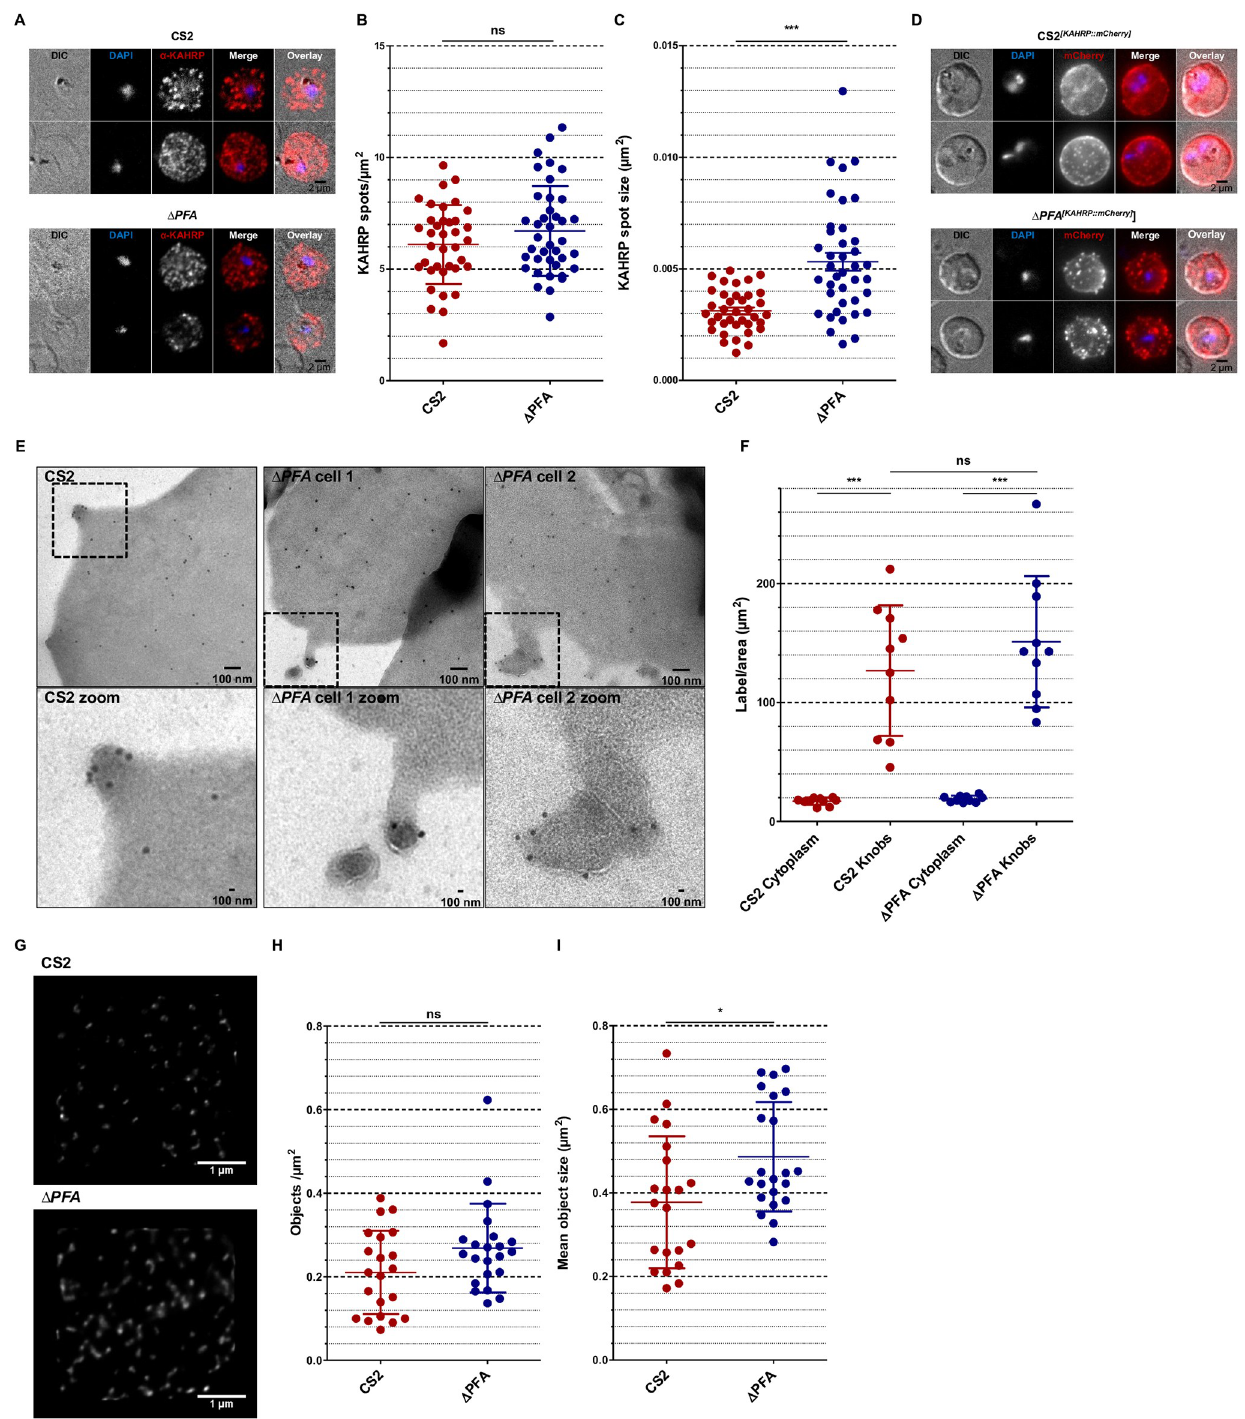
Fig 3. Δ PFA iRBCs display altered KAHRP distribution. A) IFA assay of MeOH-Ac-fixed CS2 and Δ PFA using α -KAHRP antibodies reveals punctate patterns. A trend was noticed towards bigger spots in the truncation strain and verified using automated measuring via an ImageJ algorithm (See Fig 3 B, C). D) Live cell imaging of DAPI stained CS2 [KAHRP :: mCherry] and Δ PFA [KAHRP :: mCherry] . KAHRP::mCherry can be seen in both cell lines as punctate patterns; however, CS2 displays smaller and more dots. E) Immunogold labelling of iRBC sections in TEM using α -KAHRP antibodies. Images demonstrate label associated with normal knobs and deformed knobs in CS2 and Δ PFA , respectively. Framed areas can be seen enlarged below. F) Analysis of label density associated with the cytoplasm and area surrounding knobs. Label density is significantly higher in the area surrounding knobs than the cytoplasm for